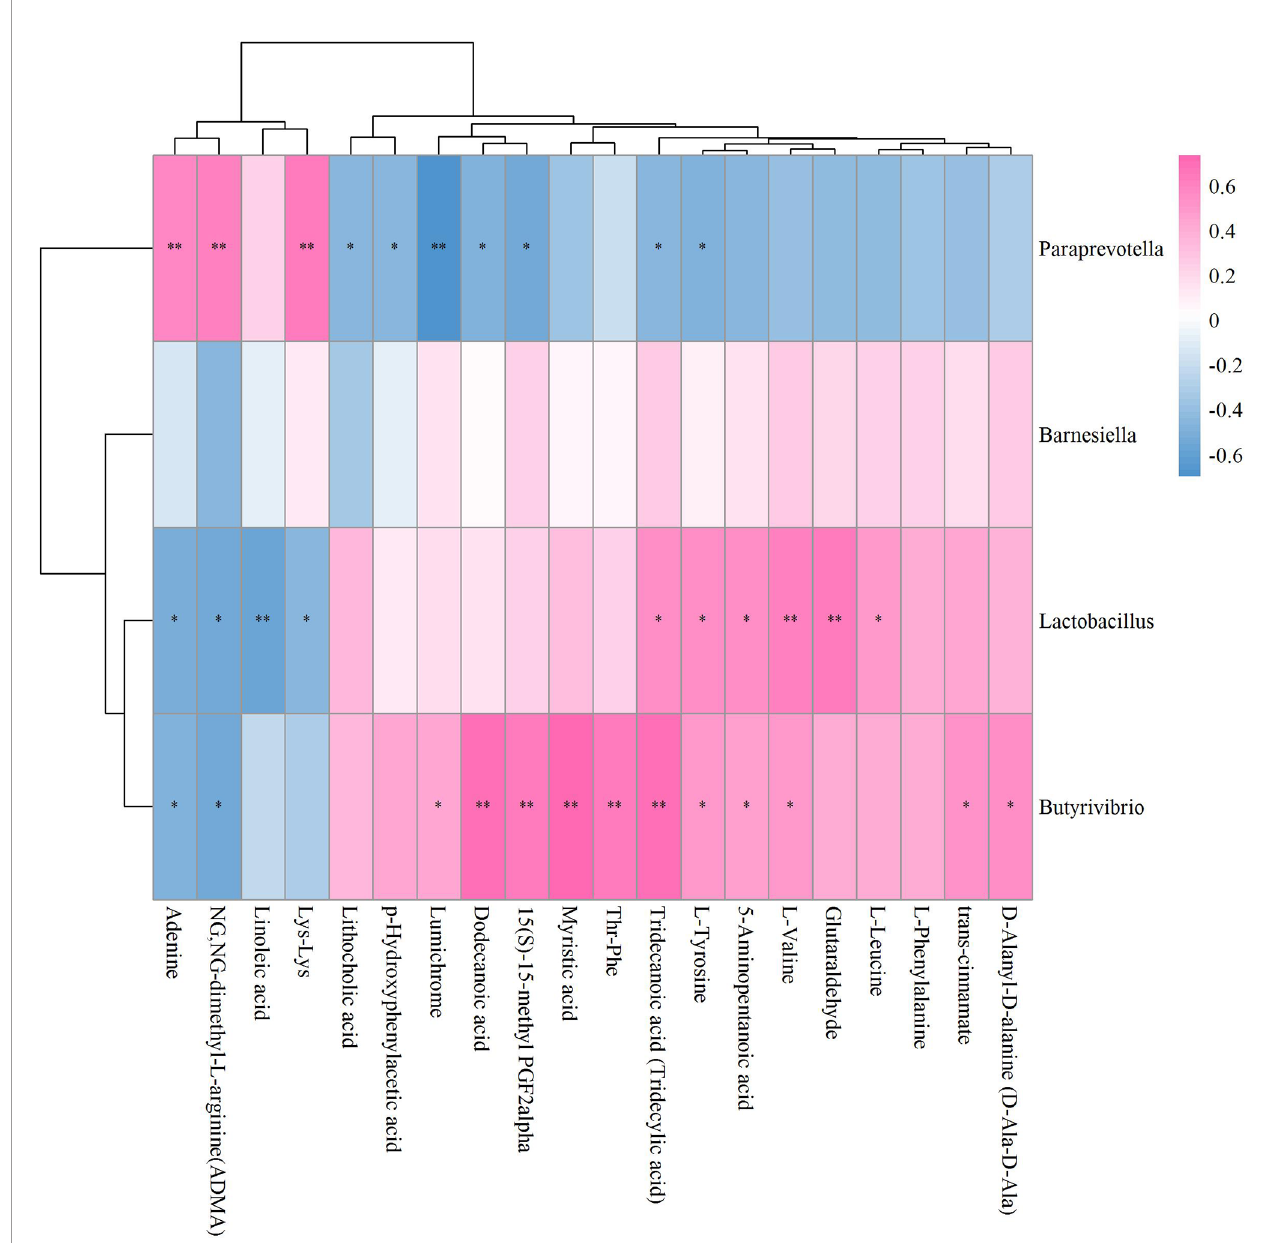
FIGURE 10 | Hierarchical clustering heat map of the signi fi cant differential GM and fecal metabolites in OVX+ICA and OVX+E2 groups based on Spearman correlation analysis (n = 10). * and ** mean a signi fi cant correlation between GM and fecal metabolites was found based on p < 0.05 and p < 0.01,